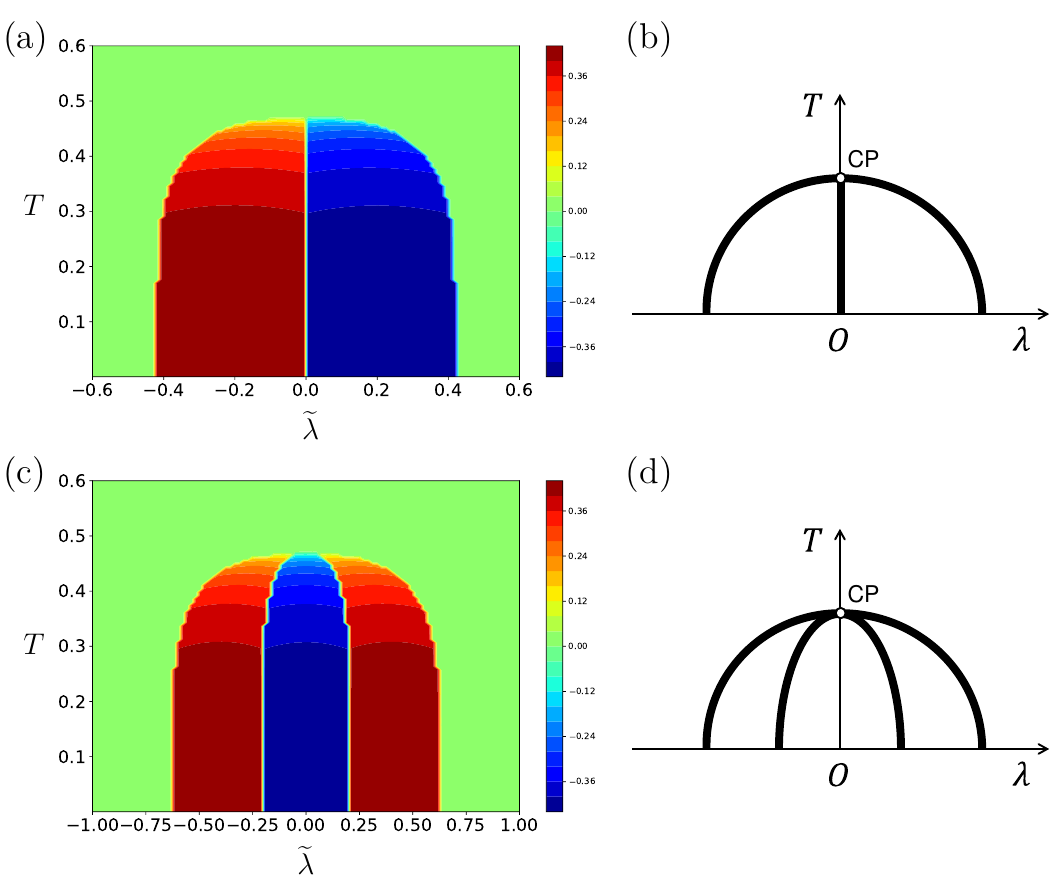
Figure 8 . (a) The phase diagram for M = 3 at µ = 0 with g 1 = 1 and g 2 = 3 in the large- N limit. e e The value plotted is e 1 − 2 e 2 + e 3 , where the ordering e 1 ≥ e 2 ≥ e 3 is assumed. (c) The phase diagram for M = 4 at µ = 0 with g 1 = 1 and g 2 = 3 in the large- N limit. The value plotted is e e e 1 − 2 e 2 + 2 e 3 − e 4 , where the ordering e 1 ≥ e 2 ≥ e 3 ≥ e 4 is assumed. The diagrams (b) and (d) are simplified versions of figures (a) and (c). There is a critical point (CP) at which all first-order transition lines meet. Again we have omitted the high temperature